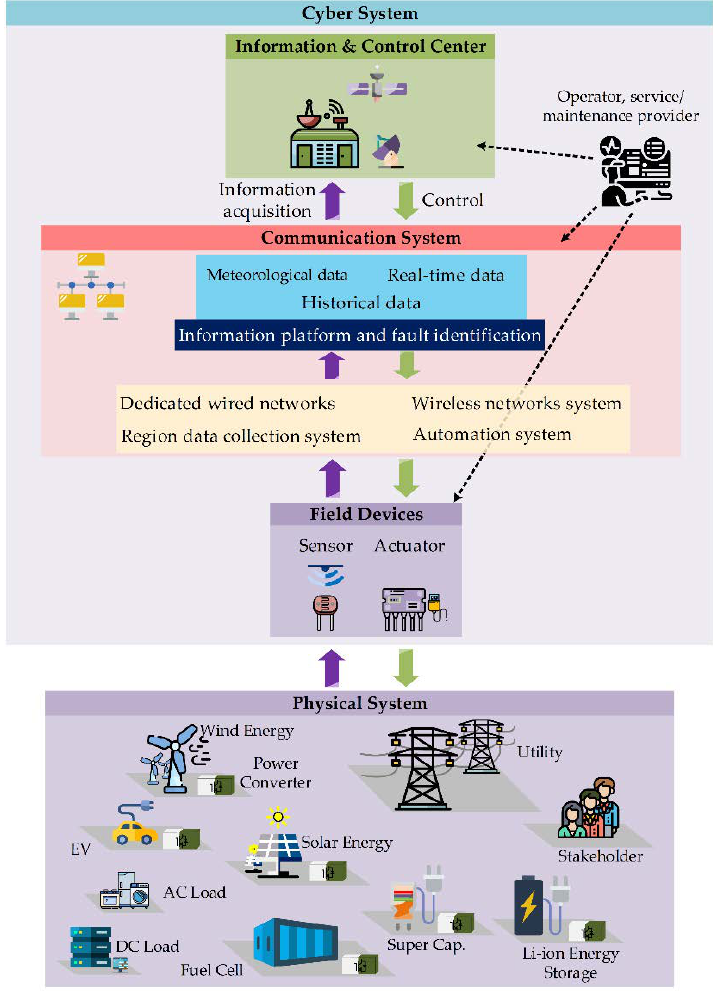
Figure 2. A typical smart microgrid with cyber-physical systems [2].